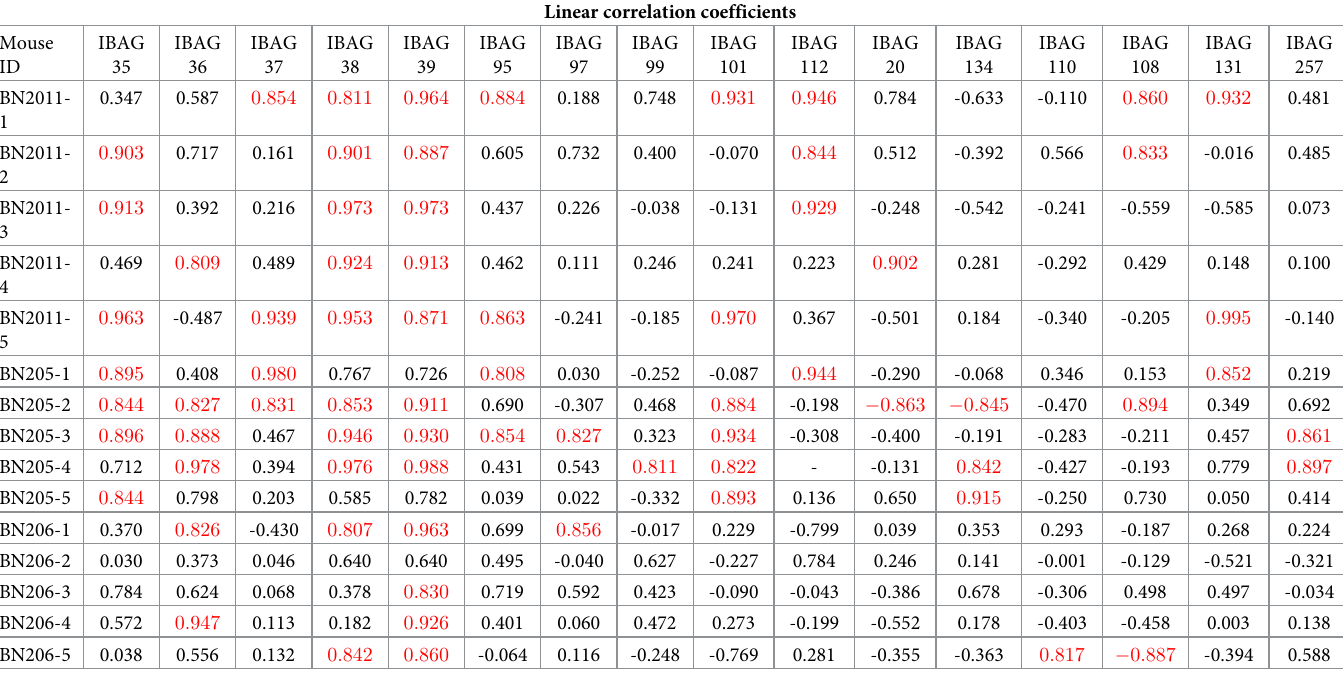
Table 2. Linear correlation coefficients of each antigen for each infected mouse treated with 100 mg kg -1 benznidazole. Correlation coefficients were calculated, for log10 (total flux) and biomarkers, for each mouse separately (n = 6 observations post-treatment). Statistically significant correlation coefficients are marked in red. Red : lin- ear correlation coefficients > 0.8 (p-value <